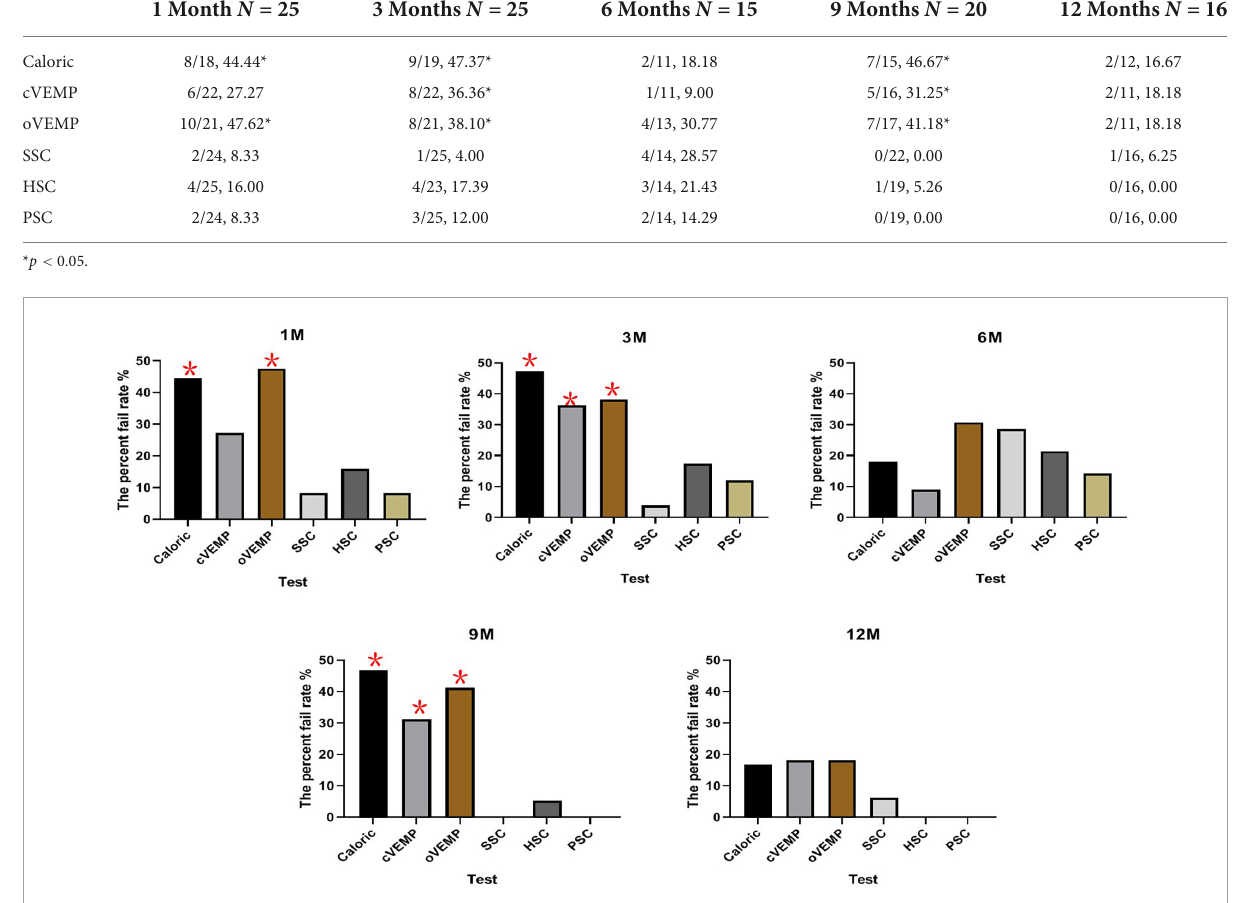
FIGURE2 The percent fail rates of all the four tests on the implanted side at each time point. The percent fail rate of caloric was significantly higher than vHIT at 1, 3, and 9 months post-operatively ( p < 0.05). The percent fail rate of oVEMP was higher than that of SSC, HSC, and PSC at 1 and 9 months; the rate was higher than that of SSC and PSC at 3 months post-operatively ( p < 0.05). At 3 and 9 months post-operatively, the percent fail rate of cVEMP was higher than that of SSC and PSC (* P <